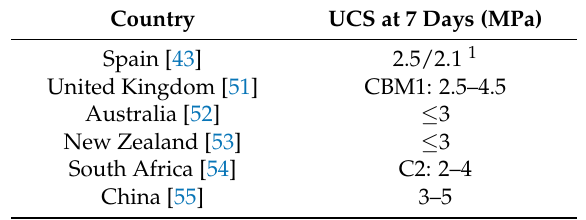
Table 2. Requirements specified in various countries for the unconfined compressive strength (UCS) of soil-cement.